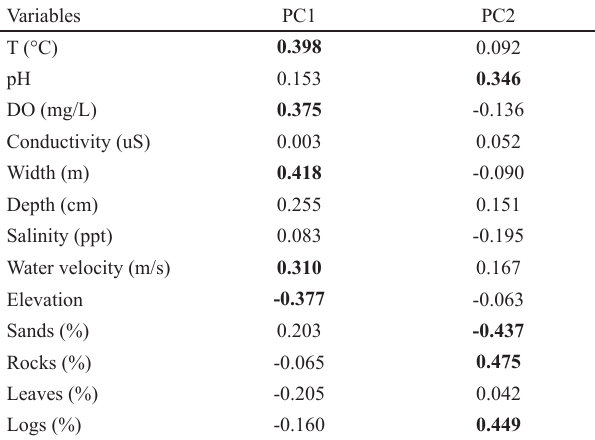
Tab. 3. Results of Principal Components Analysis